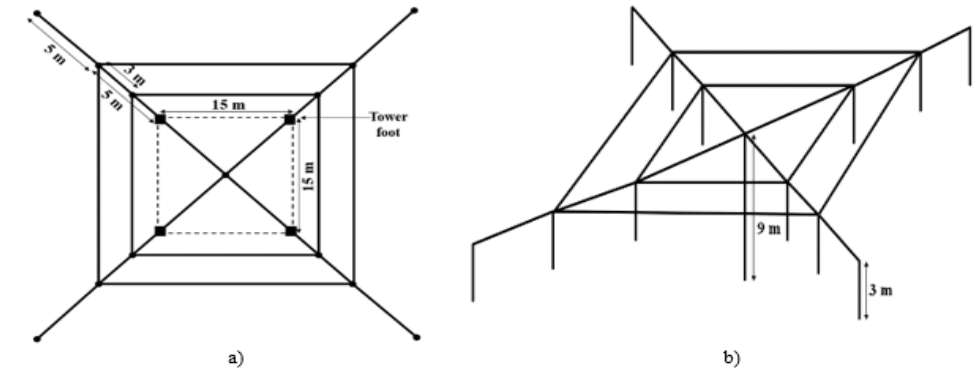
Figure 5. Design B: Radial and ring electrodes; ( a ) top view; ( b ) 3D view.